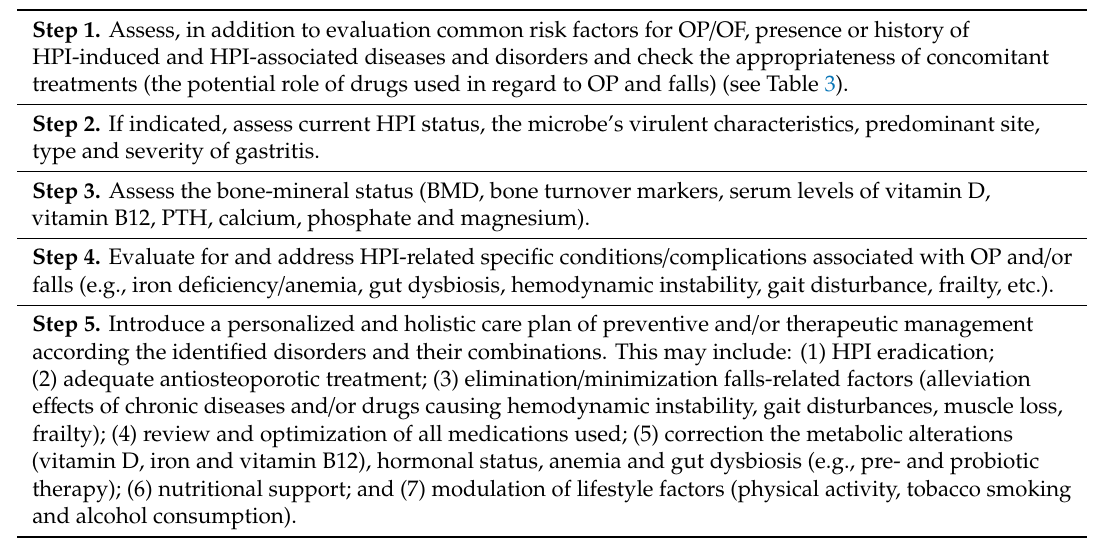
Algorithm for osteoporotic fracture risk assessment and management in regard to Helicobacter pylori